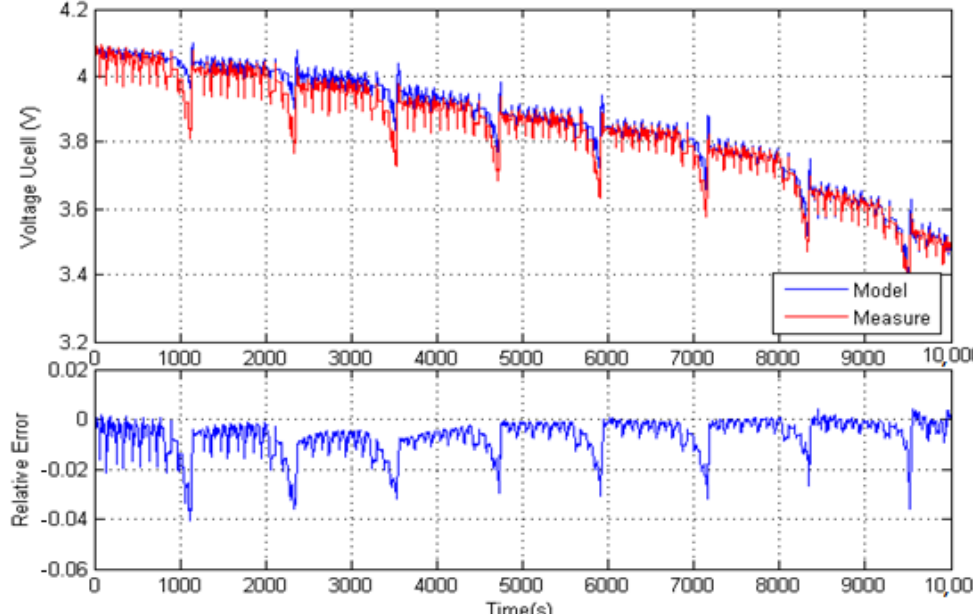
Figure 11. SOC evolution within the 8 NEDC cycles.